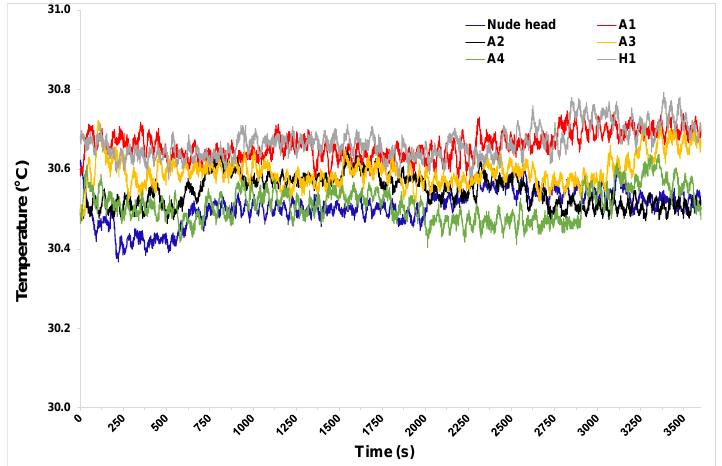
Figure 4. Surface temperature of thermal manikin measured at 39 locations (locations shown in Figure 1c) by temperature sensors during test.